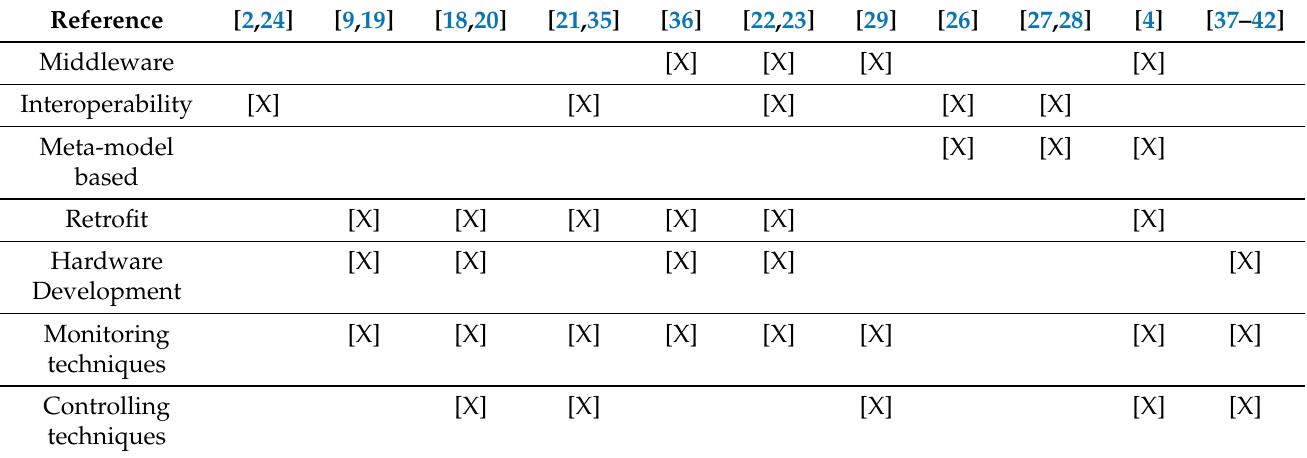
Table 1. Comparison of the main references in the literature and their